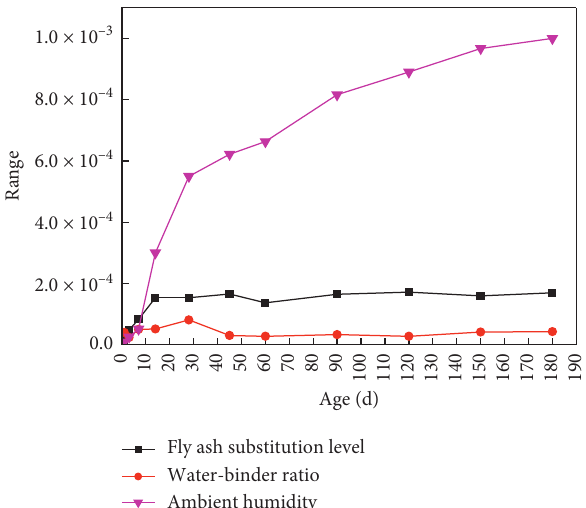
Figure 6: Shrinkage rate range across different fly ash substitution levels, water-binder ratios, and ambient humidities.